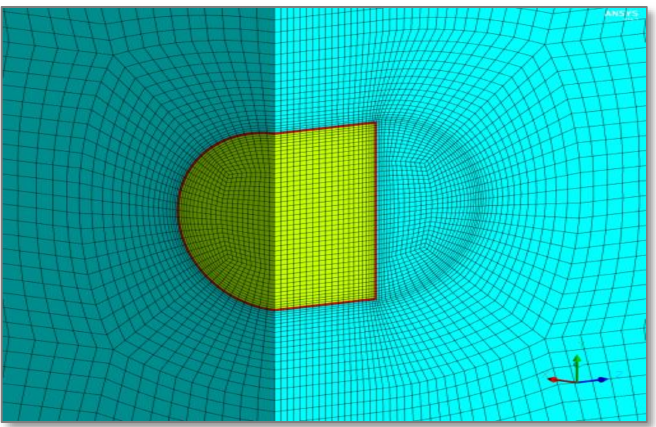
Figure 2. Discretization used in 3D simulations of the particle with L/D = 1.